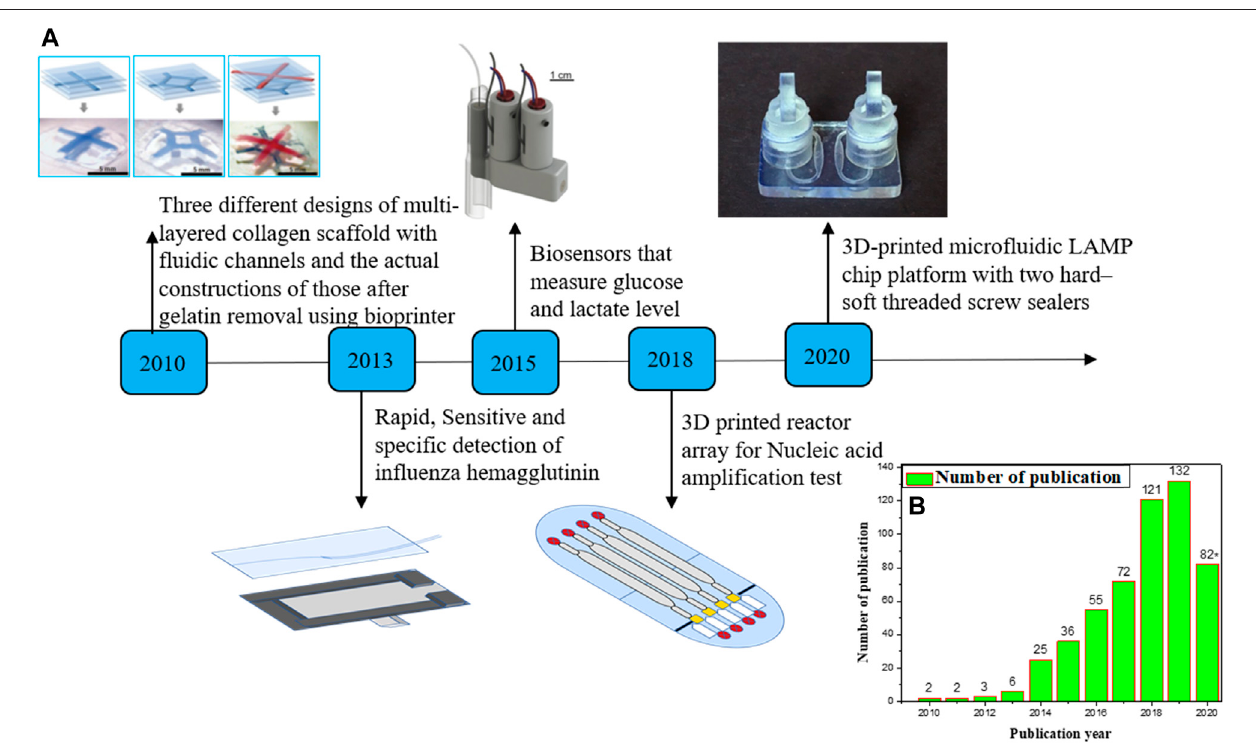
FIGURE 1 | (A) Timeline for producing 3D printing micro fl uidic devices in the last 10 years. Here, we emphasize on some examples of 3D printing micro fl uidic devices for biomedical applications. (B) The number of articles published on micro fl uidics and 3D printing annually. Data were obtained from “ Web of Science ” with “ micro fl uidics and 3D printing ” entered as “ subject ” in the search box (date: 07.09.2020). (Some portion of the fi gure is reproduced with permission of Lee et al., 2010; Gowers et al., 2015; Ruiz et al., 2020).